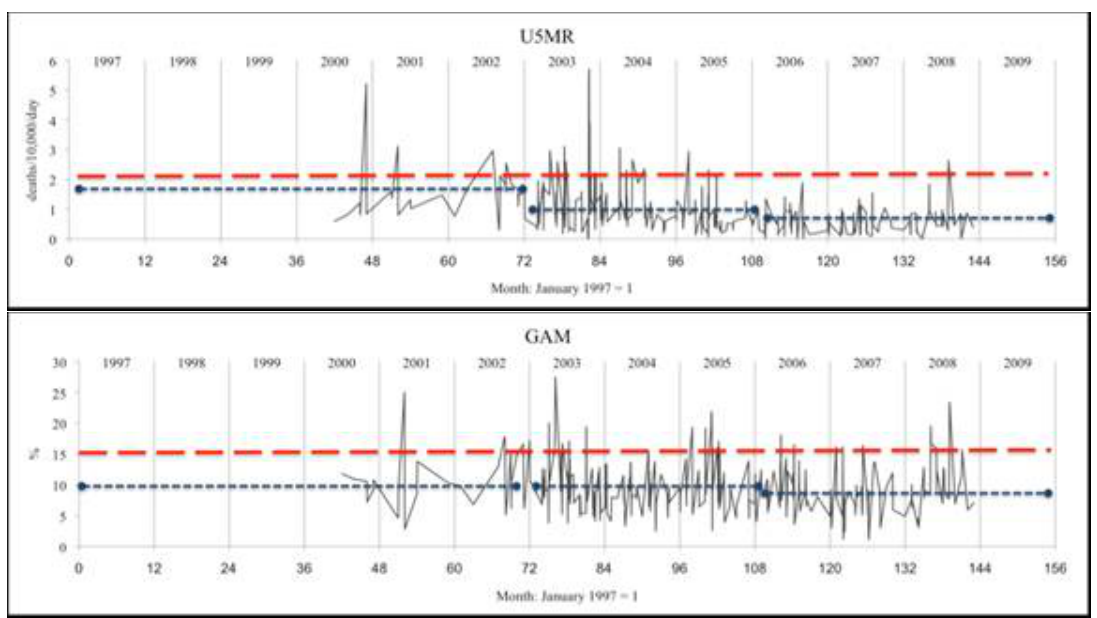
Figure 1. Cont. C: Ethiopia (agriculturalists